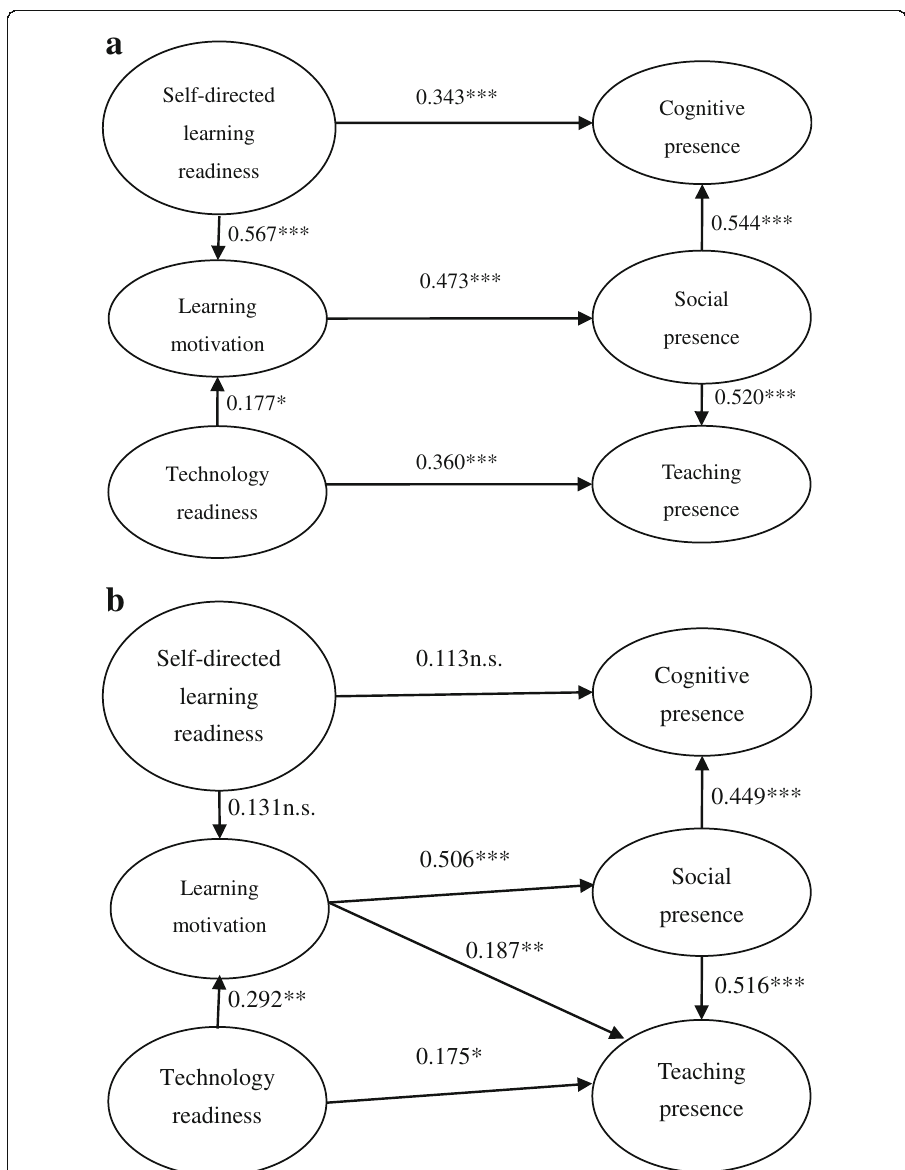
Fig. 3 a PLS result for engineering students in the BL group. b PLS result for engineering students in the NBL group